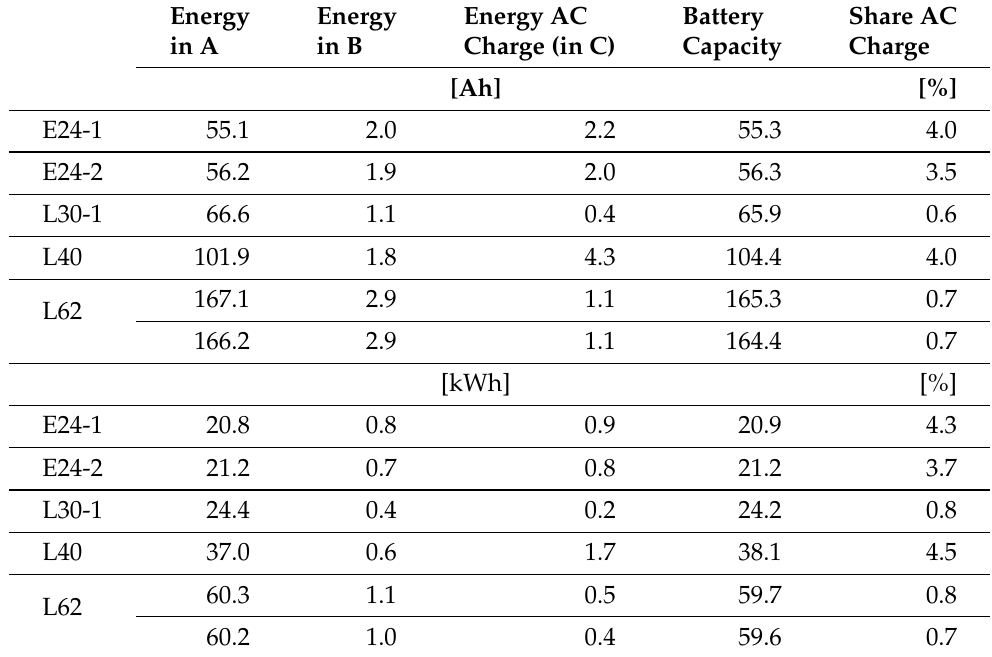
Table A2. Energy, battery capacity, and share of AC charging both considering Ah and kWh